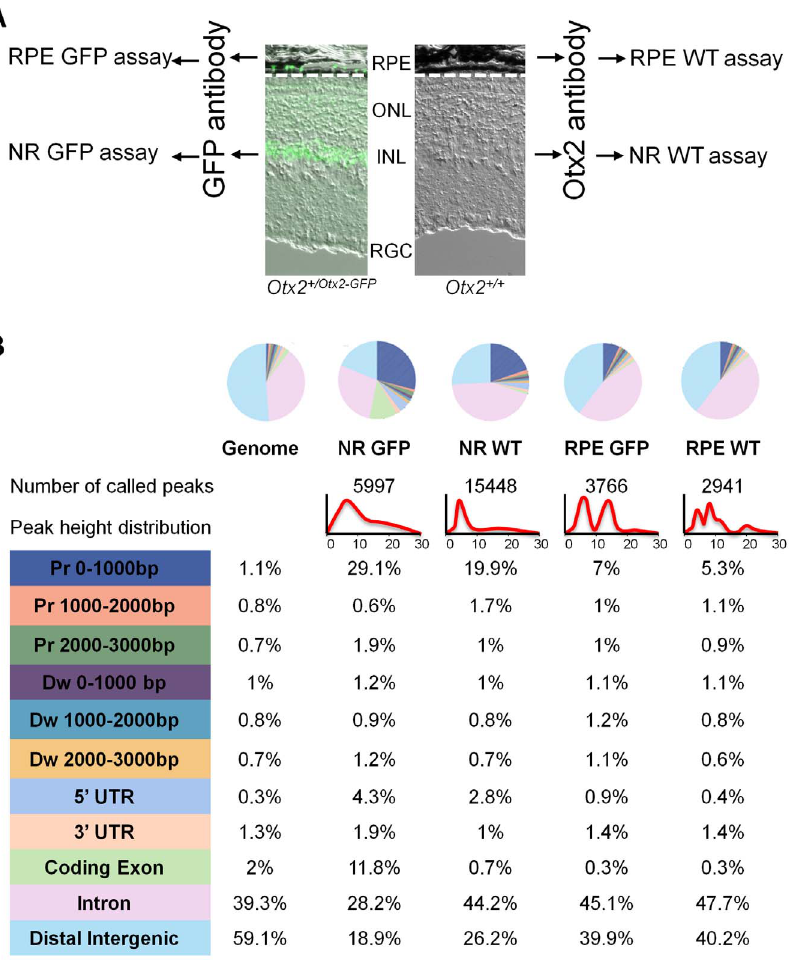
Figure 1. Tissue-specific Otx2 genome binding in the retina. A. Experimental design: four independent ChIP experiments were performed. RPE and neural retine (NR) nuclei of Otx2 + /Otx2 2 GFP mice were subjected to the GFP assays using a GFP antibody, and RPE and NR nuclei of Otx2 + / + mice were subjected to the WT assays using an Otx2 antibody. B. Genome distribution of Otx2 bound regions (OBRs). Upper panel: colour-coded pie chart showing peak distribution of each ChIP-seq assay compared to global genome distribution. Below, number of OBRs and peak height distribution of each assay are shown. Lower panel: percentage of peaks in defined functional domains of the genome for each assay. Colour-code is as in pie charts.